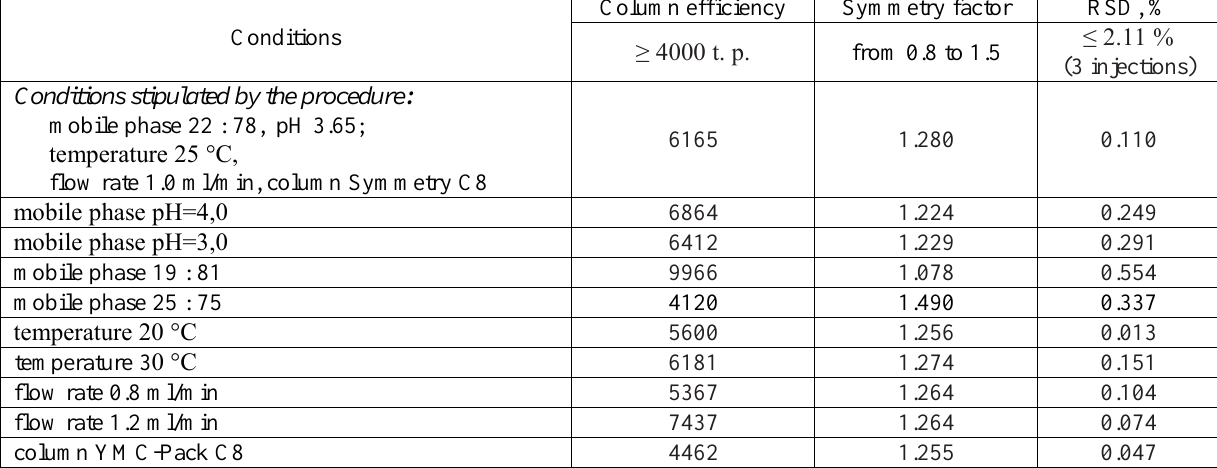
The results of the study in regard to the robustness of the analytical procedure for the quantitative determination of SS